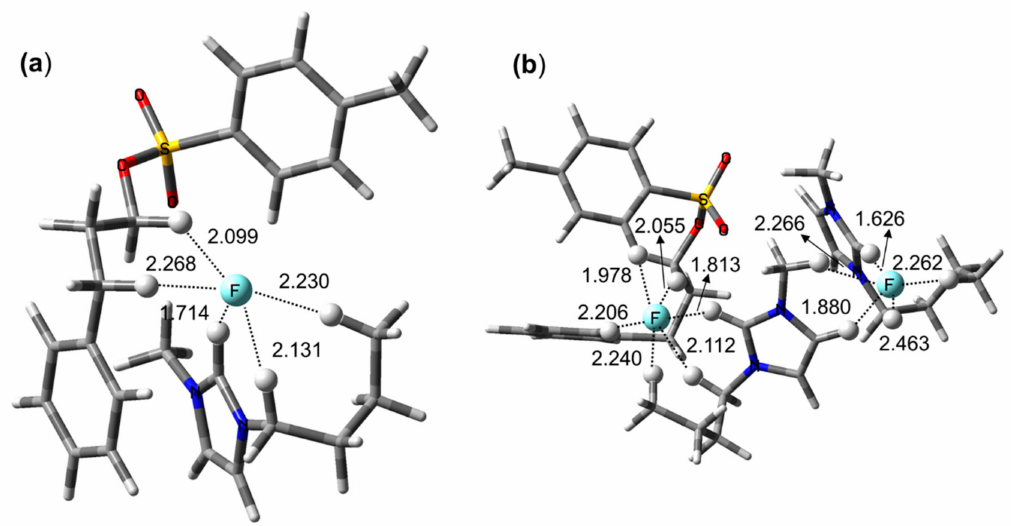
Figure 2. Pre-reaction complexes of S N 2 fluorination in [bmim][F]. ( a ) equivalent of IL = 1 ( b ) equivalent of IL = 2. M06-2X / 6-311G ** method for C, H, O, N, S, F atoms, using Gaussian 09 set of